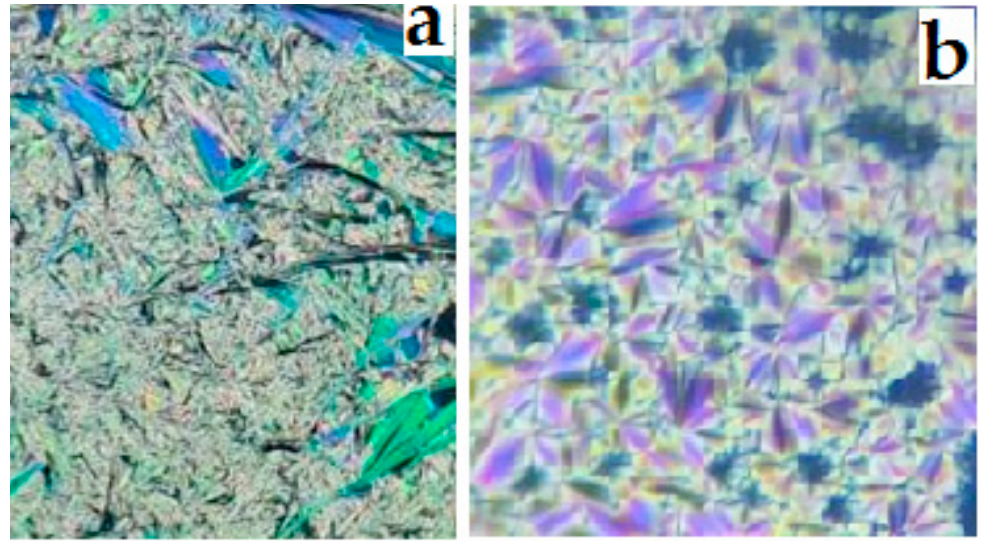
Figure 1. DSC thermograms of compounds 3.f ( a ) , 3.g ( b ) and 3.h ( c ) during first heating and cooling cycles (10 °C min − 1 ).